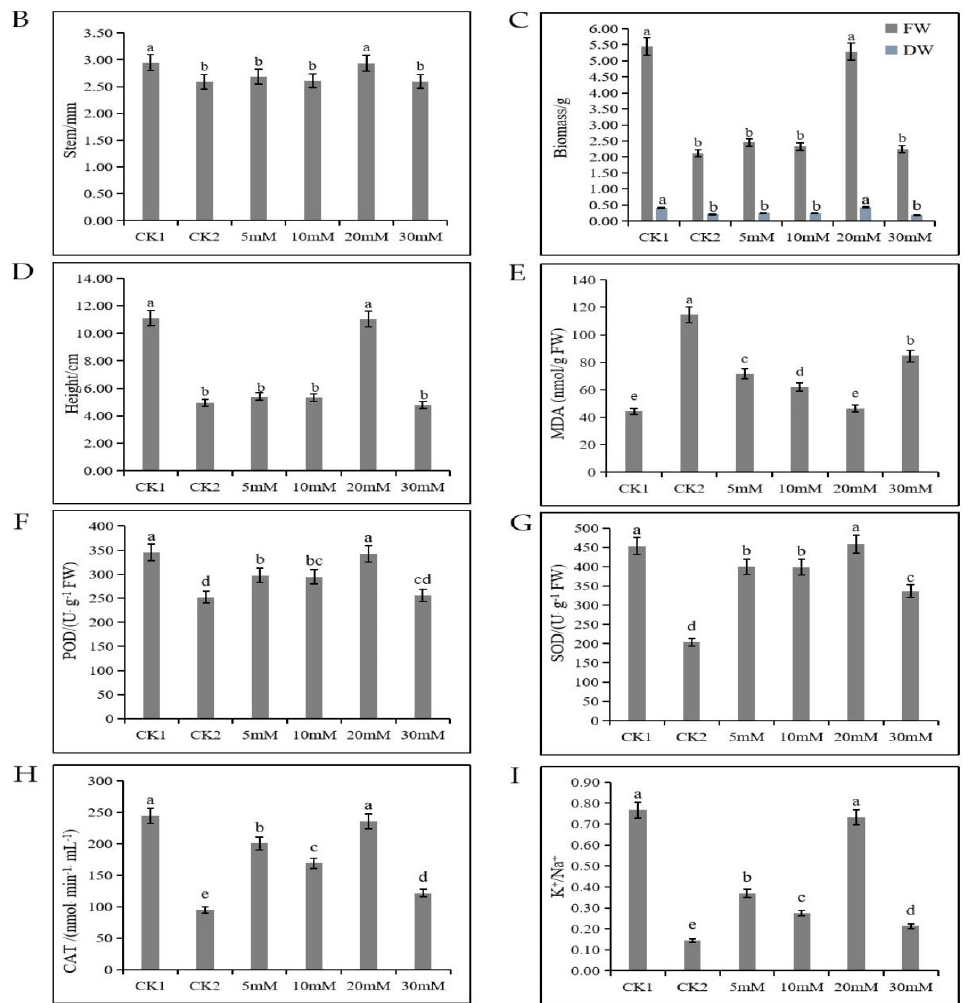
Figure 1. The effect of trehalose treatment on the growth of watermelon seedlings under 150 mM NaCl stress. ( A ) Phenotype of watermelon seedlings in Hoagland solution under trehalose and NaCl treatment for 1 week. Scale bar = 5 cm. ( B ) Measurements of the stem diameter, ( C ) biomass, and ( D ) plant height of seedlings. ( E ) MDA content, ( F ) POD activity, ( G ) SOD activity, ( H ) CAT activity, and ( I ) K + /Na + ratio of roots. Error bars indicate SE (n = 3). Small letters indicate significant differences among the different treatments ( p < 0.05). CK1 represents watermelon seedlings cultured in normal Hoagland solution; CK2 represents watermelon seedlings cultured in Hoagland solution containing 150 mM NaCl; 5 mM, 10 mM, 20 mM and 30 mM represent watermelon seedlings cultured in Hoagland solution containing 150 mM NaCl and indicated concentrations of